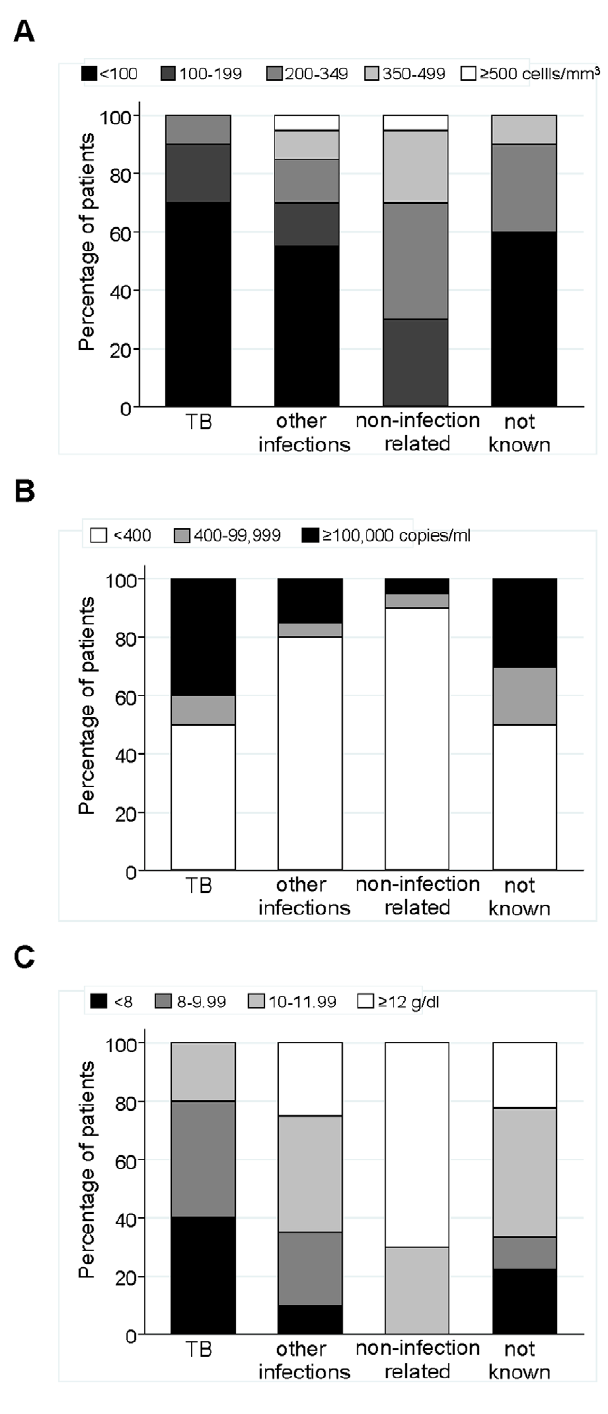
Figure 2. Distribution of most recent CD4 count (A), viral load (B) and haemoglobin (C) measurement at time of death, by cause of death. Based measurements within the last 9 months before date of death. Number of cases by cause of death: 10 TB, 20 other infections, 20 not related to infection and 10 not known.